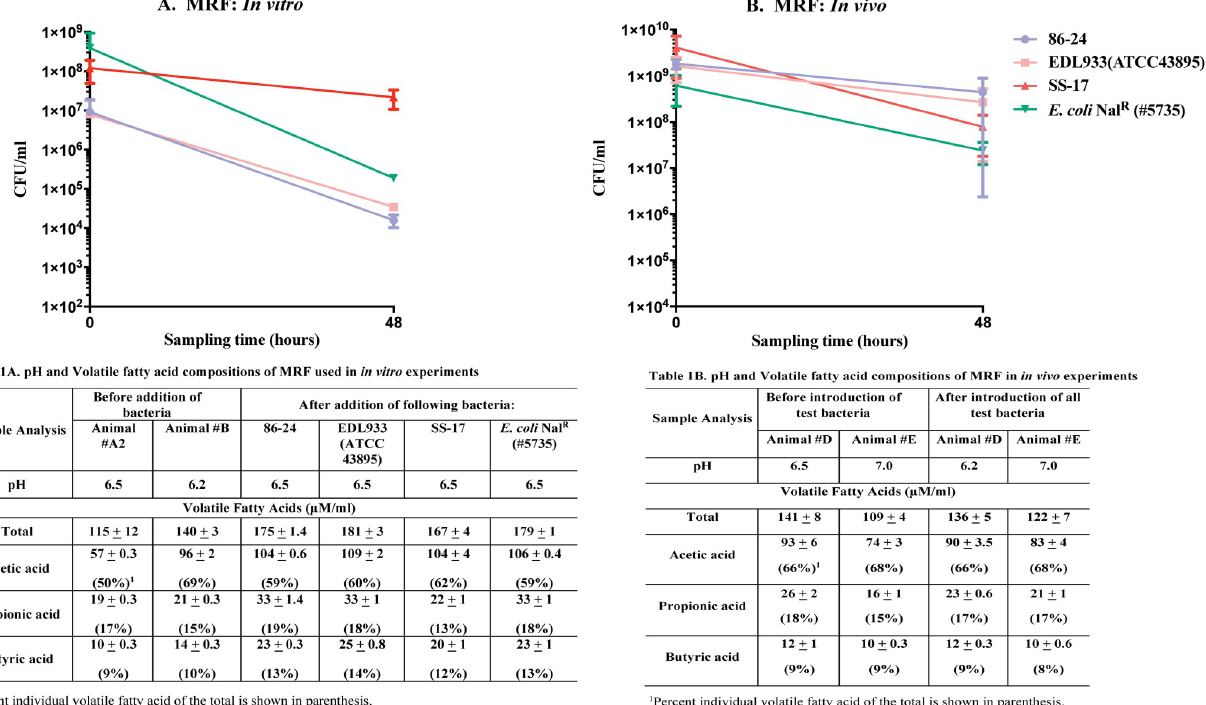
PLOS ONE | https://doi.org/10.1371/journal.pone.0268645 May 26,